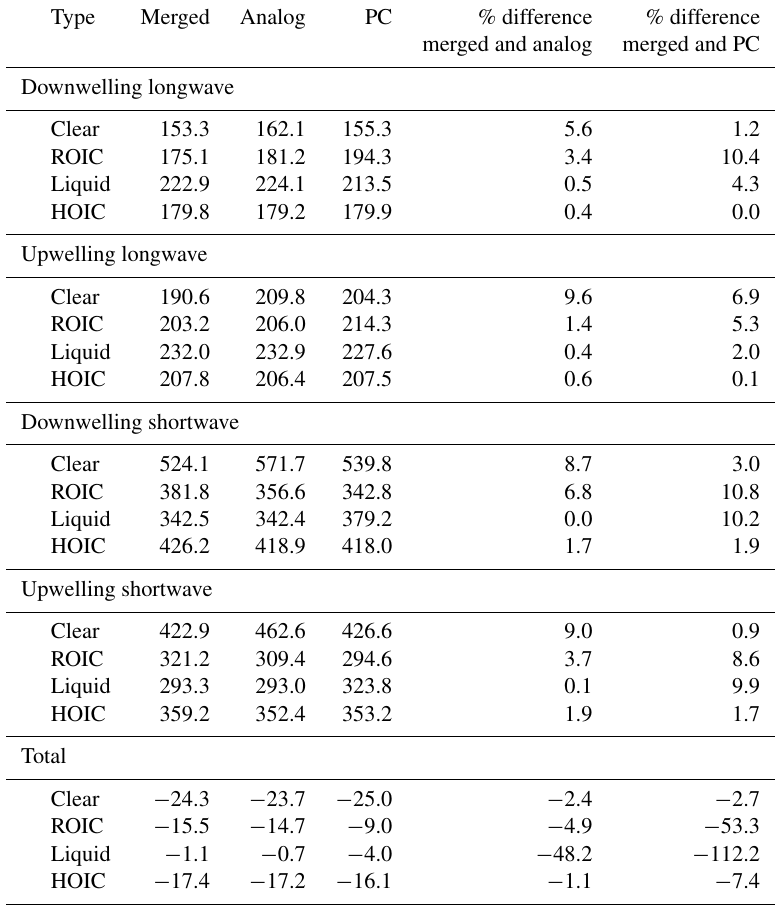
Table 6. Median values of the probability distribution function for each data processing type for each radiation component. Each radiation component is measured at the surface in units of Wm − 2 . Net flux is calculated using the relation: total = LW ↓ + SW ↓ − LW ↑ − SW ↑ . Type Merged Analog PC % difference % difference merged and analog merged and PC Downwelling longwave